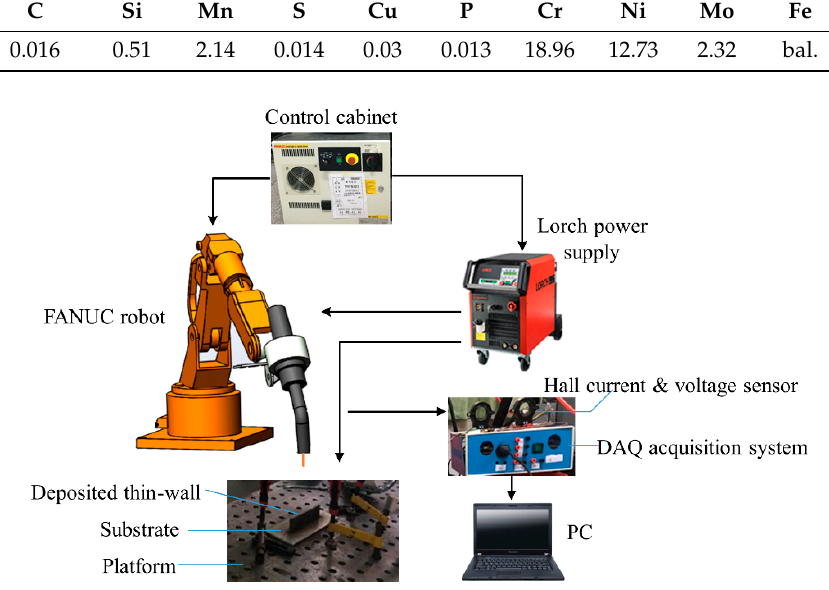
Figure 1. Schematic of MIG (metal inert gas) additive manufacturing equipment. Table 1. Chemical composition of 316L wire (mass fraction %).